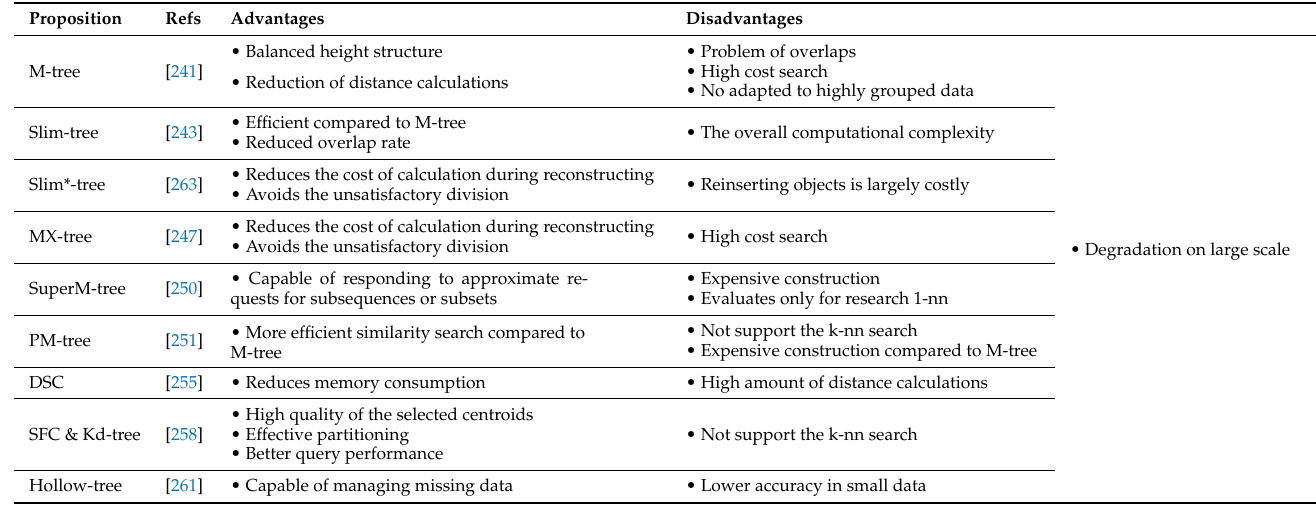
Table 16. Summary of advantage and disadvantage of metric indexing techniques based on data